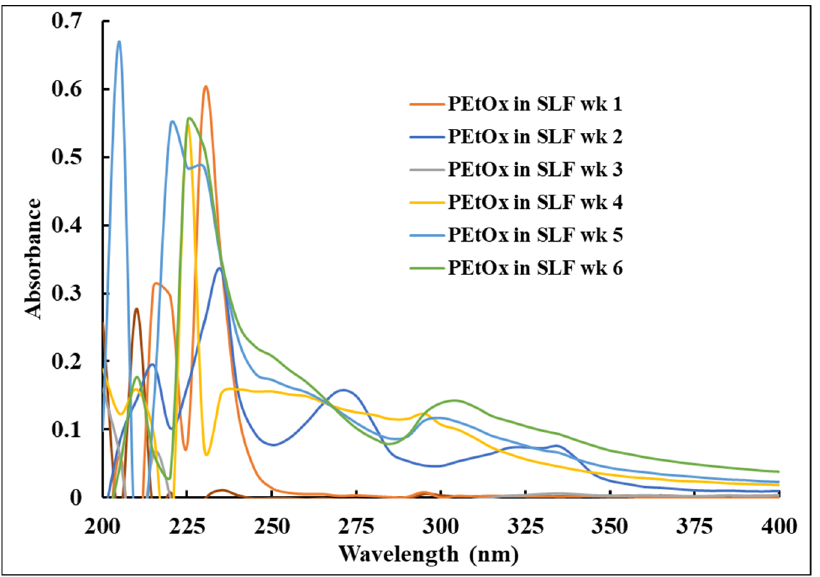
Figure 14. UV–Vis spectra of PEtOx powder at different time intervals incubated in SLF. SLF was used as the reference.